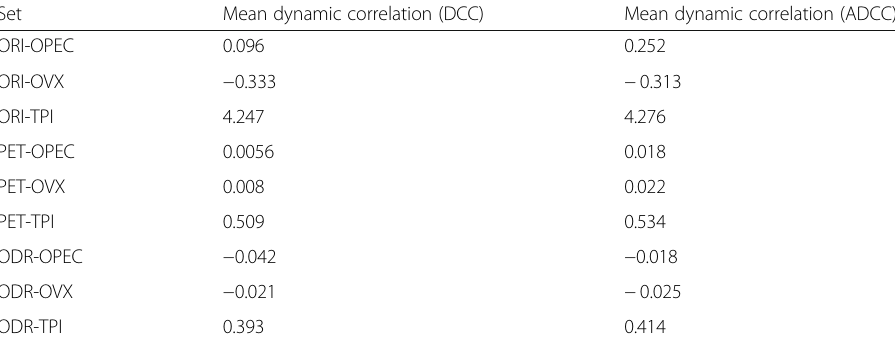
Table 5 The mean dynamic correlations, obtained from DCC/ADCC GARCH